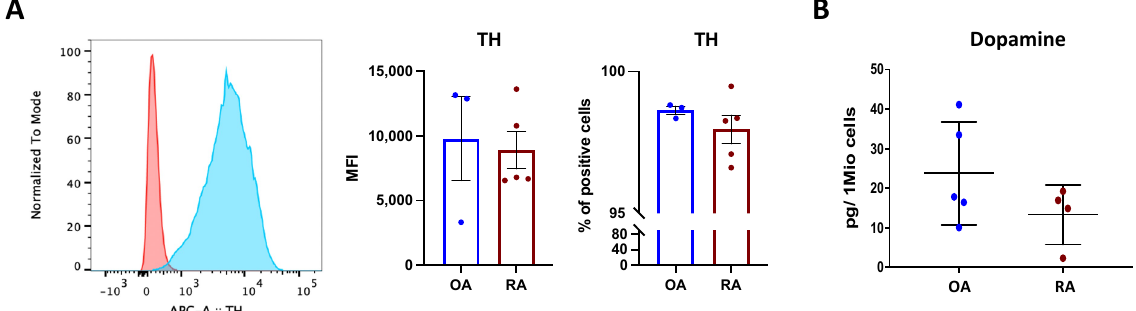
Figure 3. Dopamine synthesis in isolated osteoblasts. Tyrosine hydroxylase (TH), the rate-limiting enzyme for dopamine synthesis, was quantified in isolated osteoblasts at passage 3. ( A ): Representative histograms ( left ) showing TH expression in RA. Red: unstained control; blue: TH staining. Right: mean fluorescence intensity (MFI) and % of positive TH-stained cells in OA (blue bars) and RA (red bars). Histograms represent mean ± SEM. Each point represents one patient. OA n = 4, RA n = 5. ( B ): Quantification of dopamine content in cell lysates at passage 3, indicated as picogramm (pg) in one million (Mio) cells. Each point represents the mean value of duplicate measurements of one patient. OA n = 5, RA n = 4.